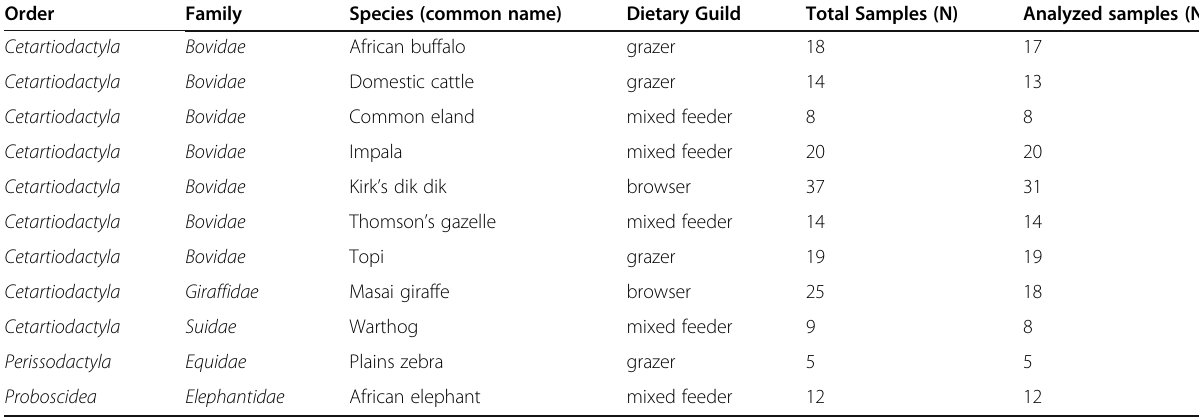
Table 1 List of host study species and their associated metadata Order Family